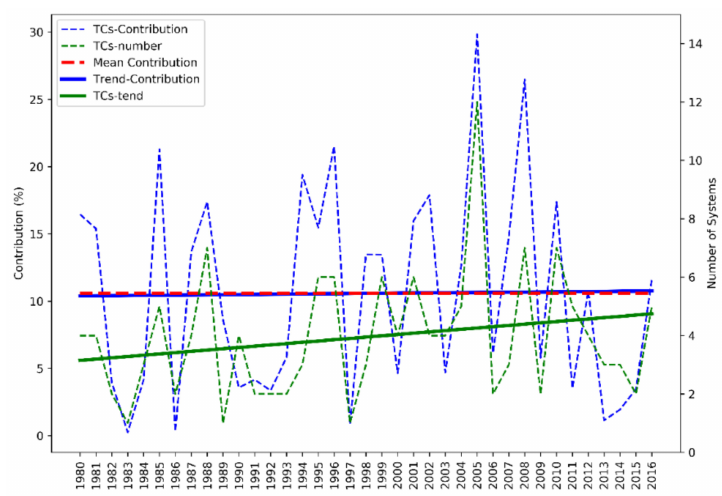
Figure 12. Temporal evolution of the total number of TCs (dashed green line), the rainfall percentage contribution of these systems (dashed blue line), the mean contribution (discontinuous red line), the trend of the contribution (continuous blue line), and the trend in TC count (continuous green line).